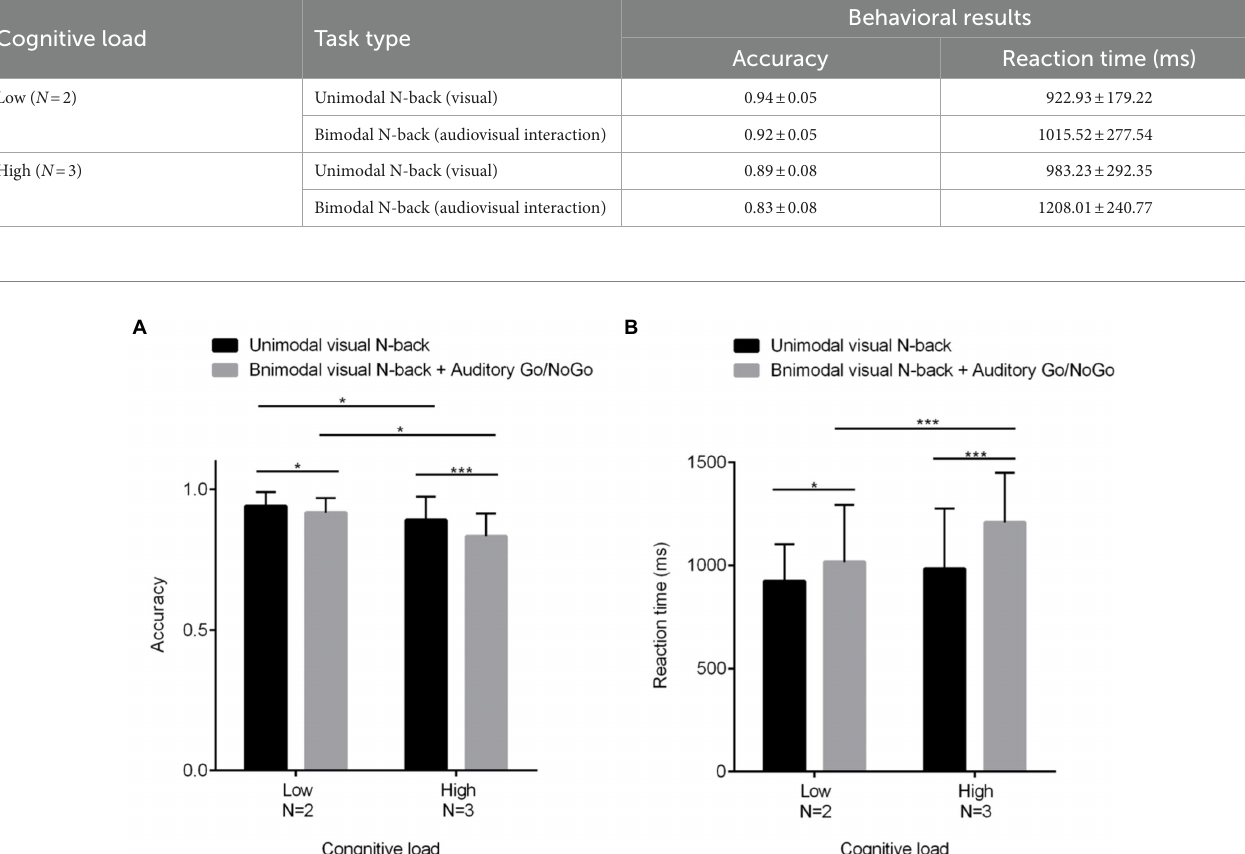
FIGURE 2 Behavioral performance (mean scores and standard deviations) in terms of accuracy (A) and reaction times (B) on unimodal and bimodal visual tasks with auditory distractors under different visual cognitive loads. Among them, N = 2 represents low cognitive load, and N = 3 represents high cognitive load. As the visual cognitive load increased, the auditory interference became more pronounced, with greater differences in terms of both reaction time and accuracy. All the data are presented as the mean ± S.D. ( n = 60); * p < 0.05, ** p < 0.01, *** p <